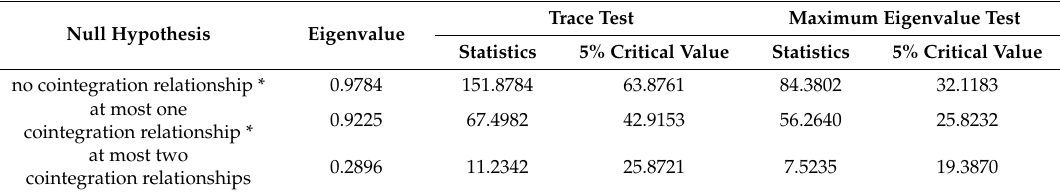
Table 4. Johansen–Juselius (JJ) Cointegration Test